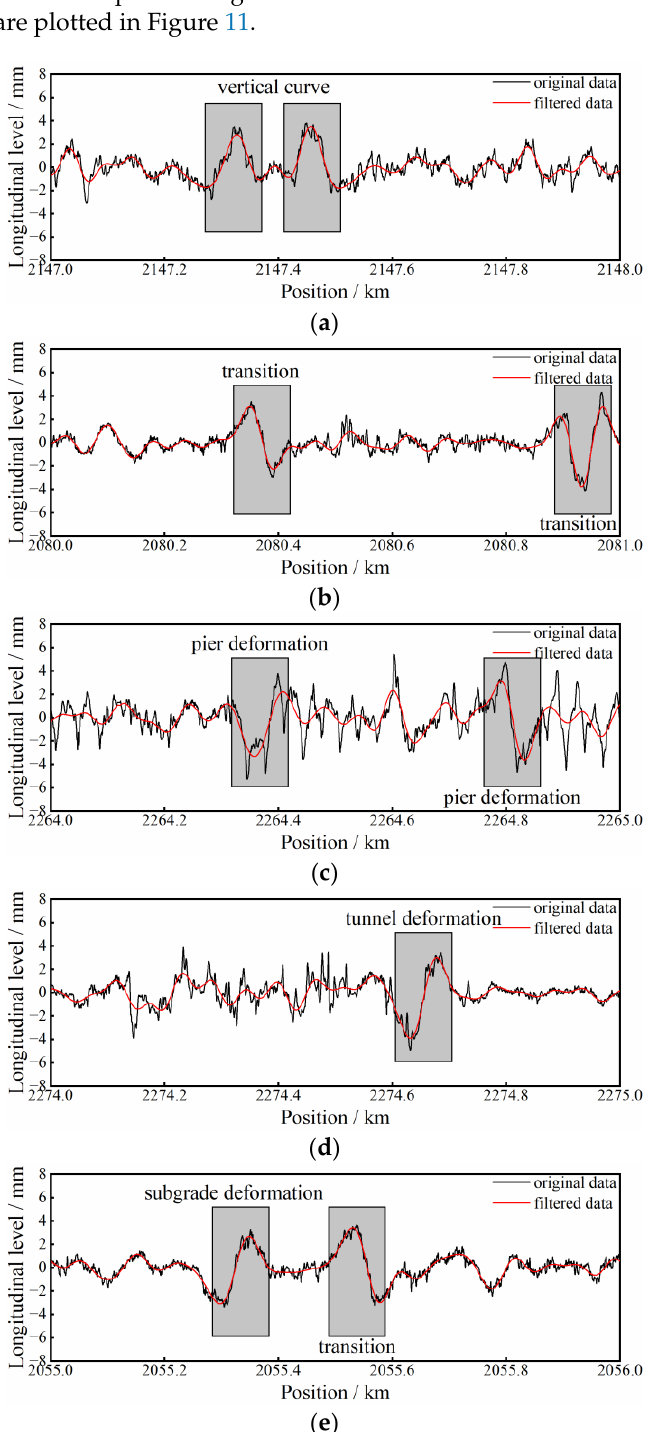
Figure 11. Waveform examples of different deformation types: ( a ) vertical curve; ( b ) transition; ( c ) pier deformation; ( d ) tunnel deformation; ( e ) subgrade deformation and transition.